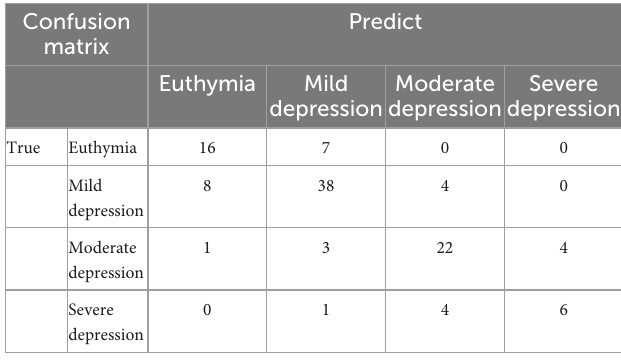
TABLE 5 Performance of MGMT in depressive symptoms evaluation (MDD-MDD).